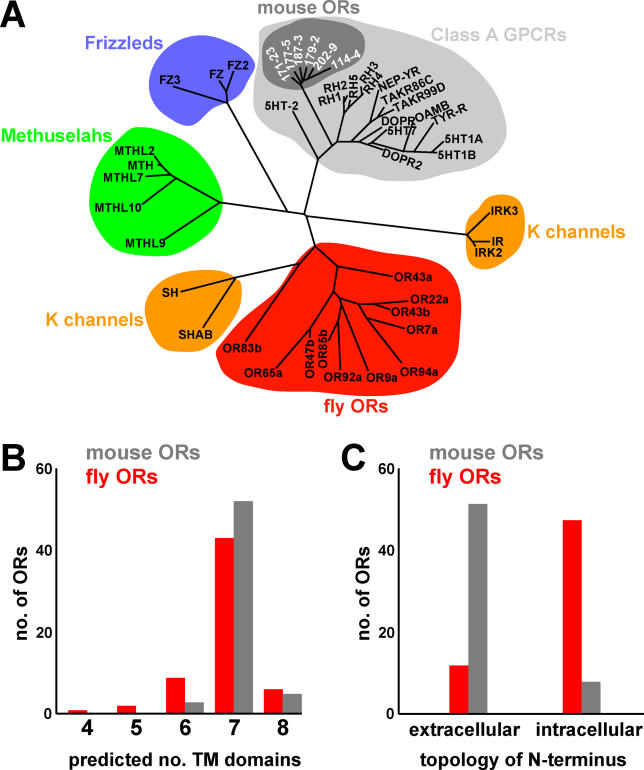
Bioinformatic Analysis Defines Drosophila ORs As a Novel Family of TM Proteins(A) Unrooted neighbor-joining tree of selected Drosophila ORs [37], Class A GPCRs [84], Methuselah family receptors [85], Frizzled receptors [86], potassium channels, and mouse ORs [87]. Sequences were aligned in ClustalX with 1000 bootstrap iterations.(B) TM domain predictions of Drosophila ORs (n = 61) and a representative subset of mouse ORs (n = 61) by the HMMTOP version 2.0 algorithm, including all those ORs depicted in (A).(C) Membrane-insertion orientation predictions of Drosophila and mouse ORs (same sets as in (B)) by HMMTOP version 2.0. All mouse ORs mispredicted to have an intracellular N-terminus (8/8) and most Drosophila ORs predicted to have an extracellular N-terminus (8/12) are not predicted to have seven TM domains, suggesting that this algorithm may have difficulty in analyzing these particular sequences.